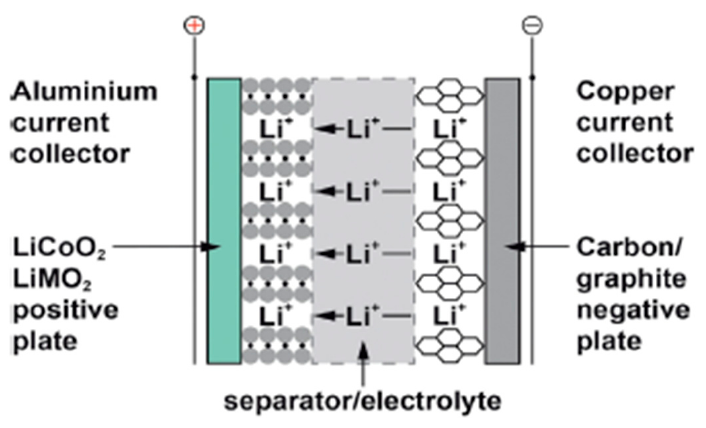
Figure 7. Chemistry and principal components of a lithium-ion battery.